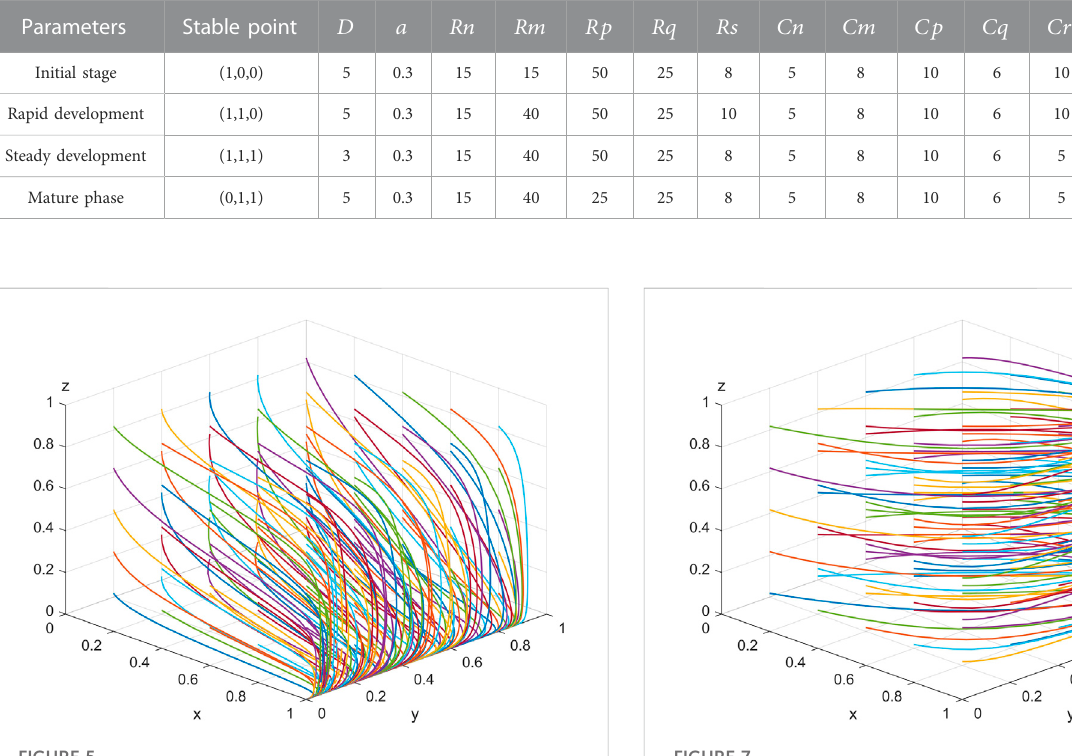
FIGURE 5 System evolution in the initial stage.